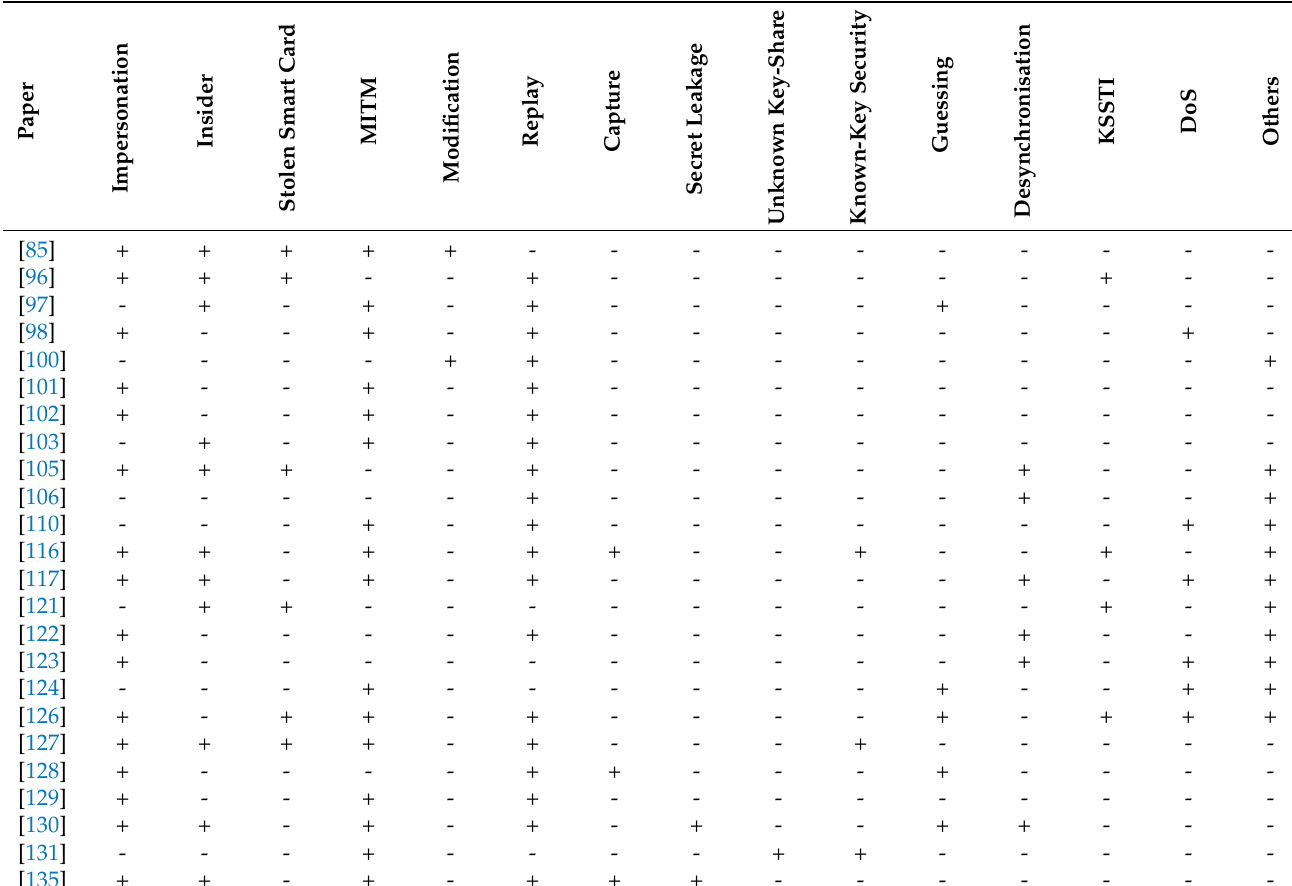
Table 4. The summary of attacks upon the